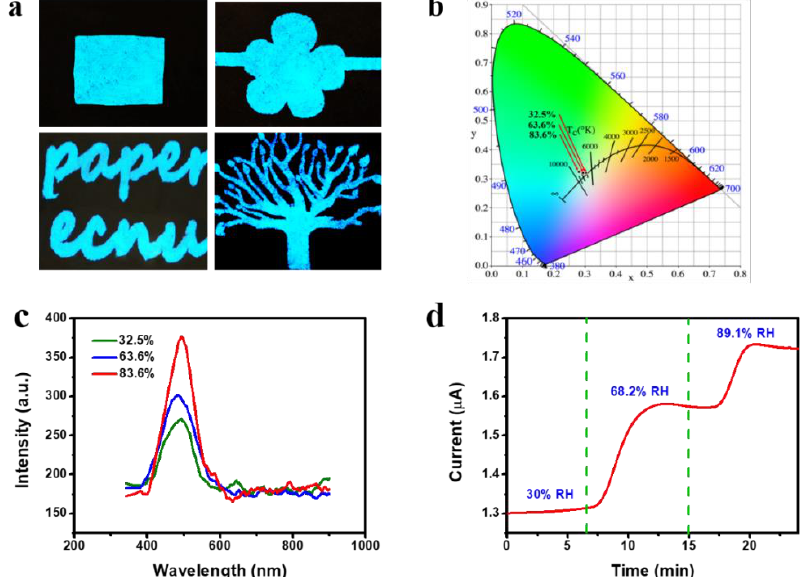
Figure 3. ( a ) EL images of ACEL device fabricated on polyimide. ( b ) Commission International edel’Eclairage (CIE) chromaticity diagram of the (x,y) color ordinates of the device varying with RH. ( c ) EL spectra of the device in different relative humidity (32.5%, 63.6%, 83.6%) at room temperature. ( d ) Current versus time plot at different (%) RH level.